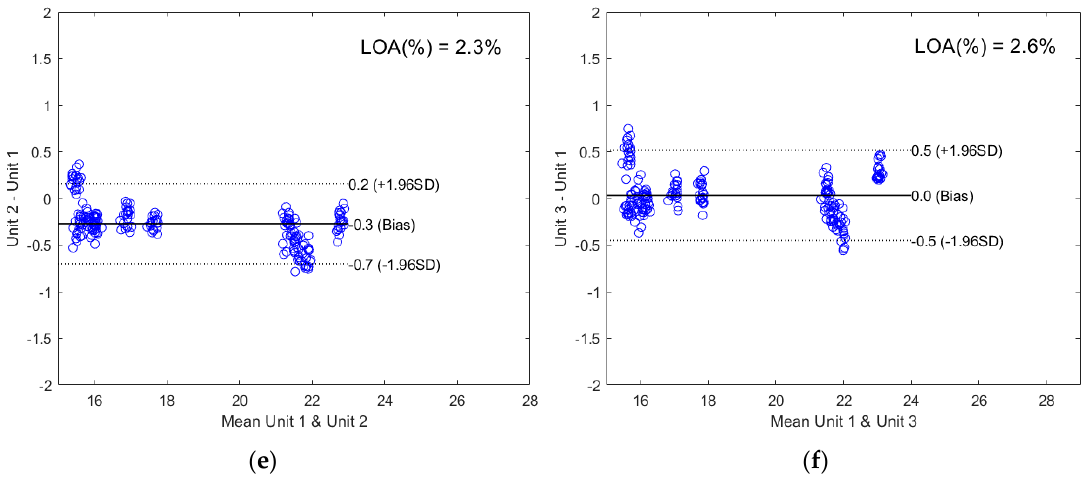
Figure 4. The Bland-Altman plots comparing the cross-unit prediction results and the same-unit prediction results using models developed on Unit 1: ( a ) validation sets by Unit 1 and Unit 2 for ASA prediction; ( b ) validation sets by Unit 1 and Unit 3 for ASA prediction; ( c ) validation sets by Unit 1 and Unit 2 for ASC prediction; ( d ) validation sets by Unit 1 and Unit 3 for ASC prediction; ( e ) validation sets by Unit 1 and Unit 2 for CAF prediction; ( f ) validation sets by Unit 1 and Unit 3 for CAF prediction. The corresponding reduced Hotelling’s T 2 and reduced Q residuals are shown in Figure 5.